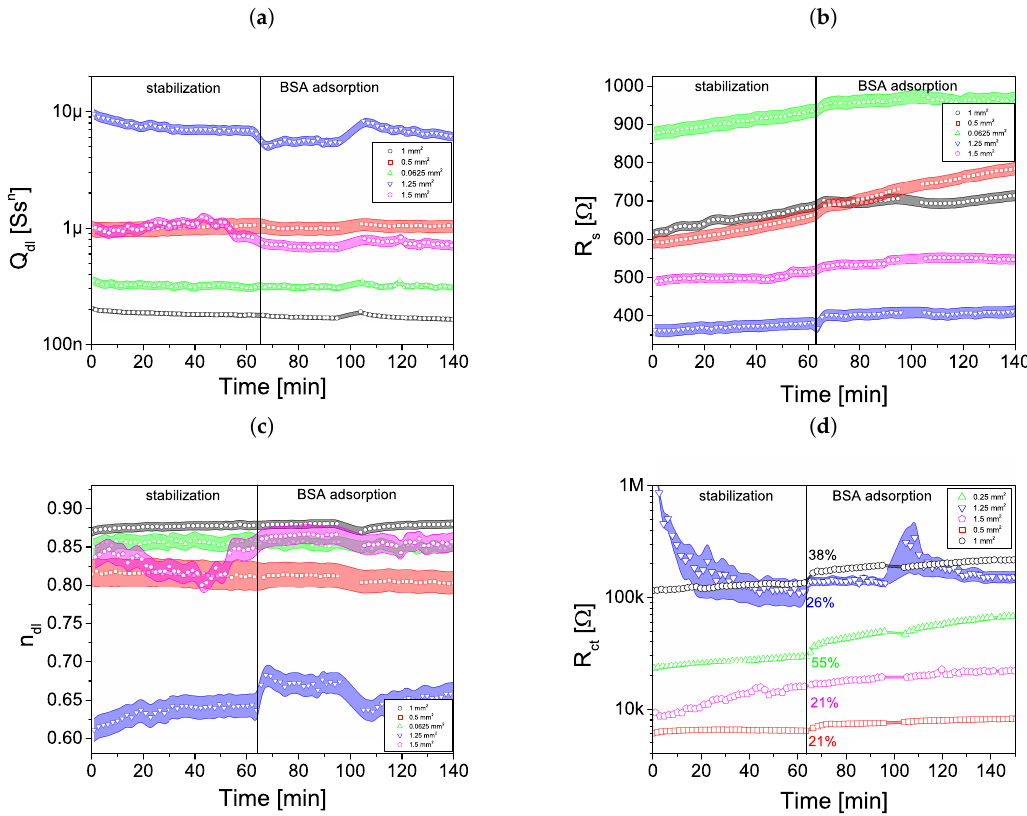
Figure 11. Parameters of electrical equivalent circuit as a function of time: ( a ) Q dl , ( b ) R s , ( c ) n dl and ( d ) normalized R ct